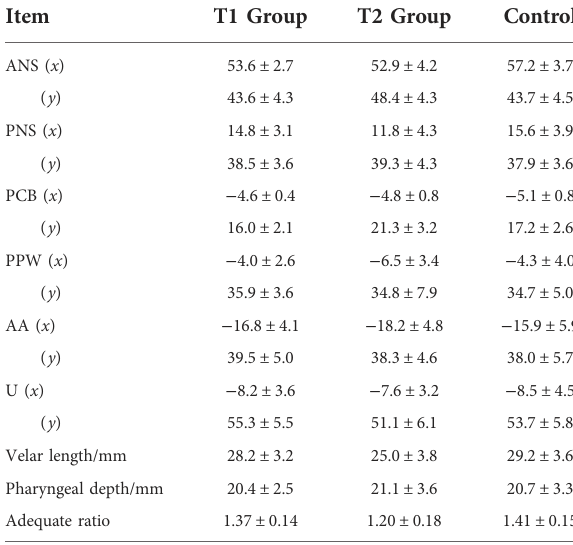
T1 group, furlow palatoplasty; T2 group, sommerlad palatoplasty. ANS, anterior nasal spine; PNS, posterior nasal spine; PPW, posterior pharyngeal wall; N, nasion; S, center of the sella turcica; PCB, pterygoid cranial base; AA, atlas; U, uvula, tip of the uvula when at